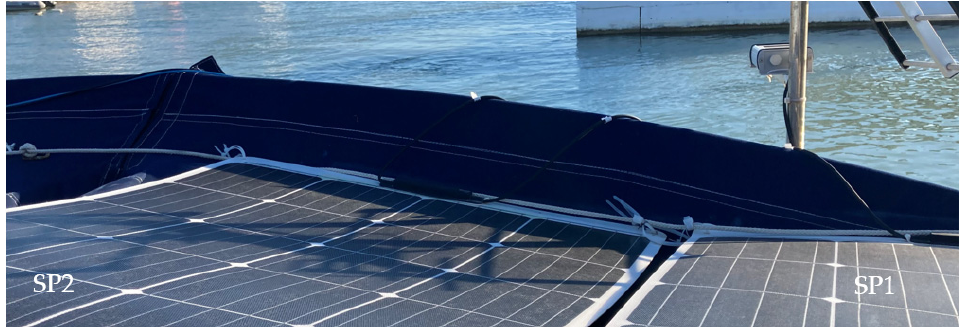
Figure 14. Shading shift from SP1 to SP2 at 16:00 h due to the antenna mast and sensors.